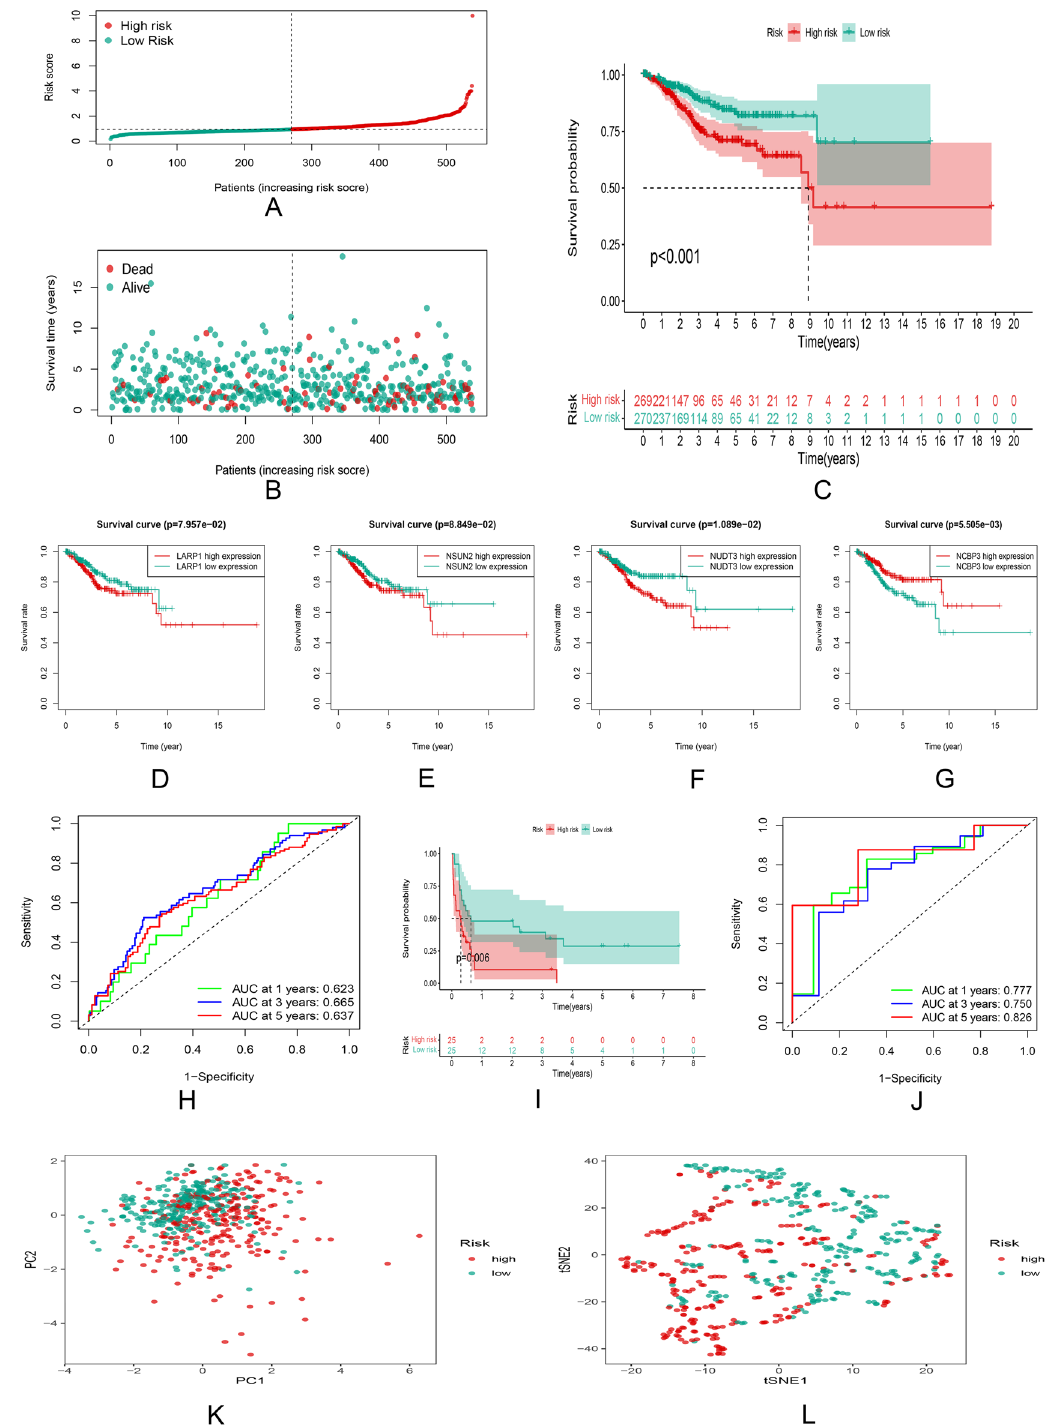
Figure 4. Survival analysis and comparison between the high and low risk groups. ( A,B ) Median distribution of risk scores and survival status of UCEC patients. ( C ) Kaplan–Meier survival curves of patients in the high and low risk groups in the TCGA cohort. ( D–G ) Survival status of high and low expression groups with NSUN2, NUDT3, LARP1 and NCBP3 genes. ( H ) ROC curves and AUC values of the model in the TCGA cohort. ( I ) PCA analysis results. ( J ) t-SNE analysis